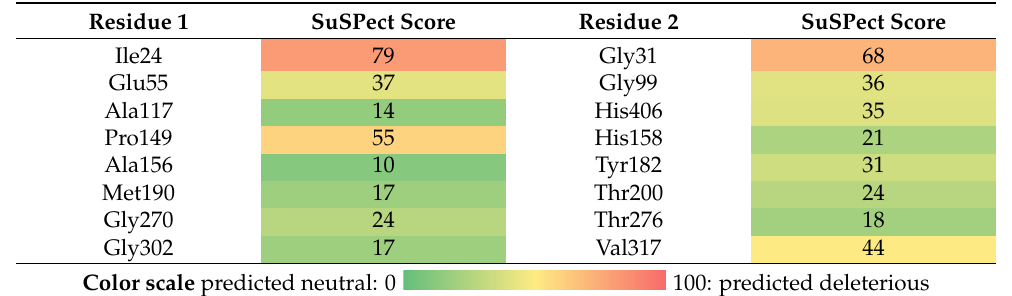
Table 3. SuSPect analysis of cysteine mutations on GOx sequence. (Residue numbers are according to the PDB 3QVP).